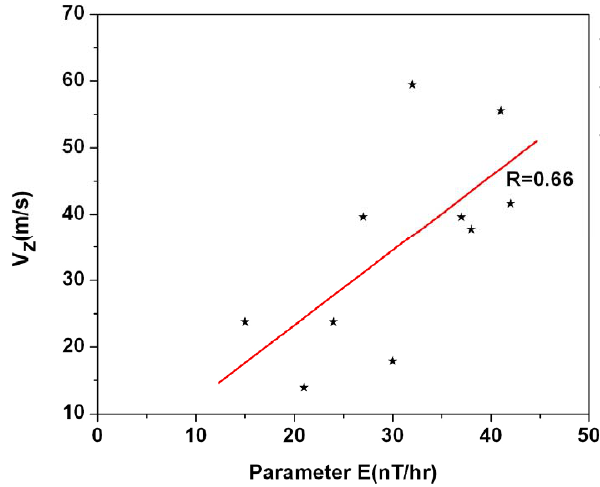
Fig. 4a. Scatter plot of the parameter “E” versus V z for some inter-